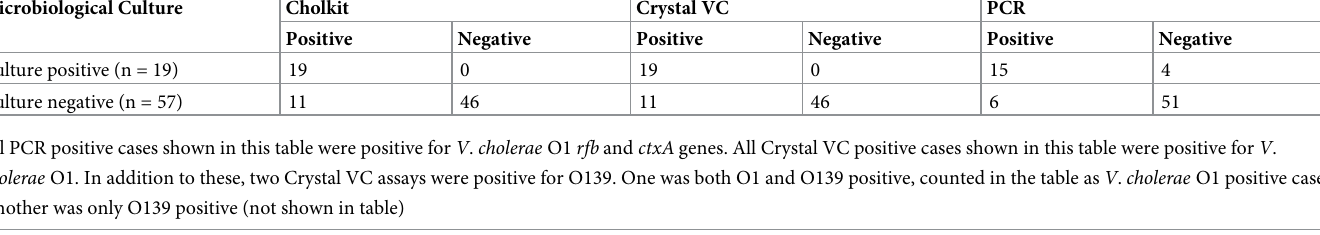
and 15 (79%) were positive by PCR (Table 2 and Fig 3). Of all patients with a negative stool cul- ture (n = 57), Cholkit, Crystal VC and PCR were positive for 11 (19%), 12 (21%), and 6 (11%), respectively. Six specimens that were culture negative but PCR positive were also positive by both Cholkit and Crystal VC. In addition to these 6 samples (culture negative but PCR posi- tive), both RDTs were positive for 5 additional stool specimens, of which one Crystal VC assay result was positive for both O1 and O139. The Crystal VC assay was also positive for one other study participant for only O139, but negative by all other tests, and this result was considered a false positive as no V . cholerae O139 was circulating at the time. A detailed listing of results by serogroup and serotype are included in Table 2.